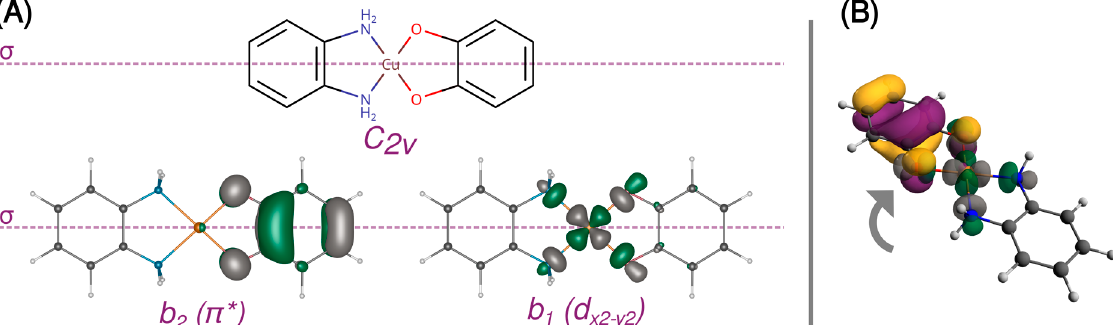
Figure 3. Orthogonal magnetic orbitals in [Cu(SQ)(opd)] + with the mirror plane σ ( A ) and the inef- fective overlap between them ( B ). The isosurfaces were contoured at 0.05 a.u.